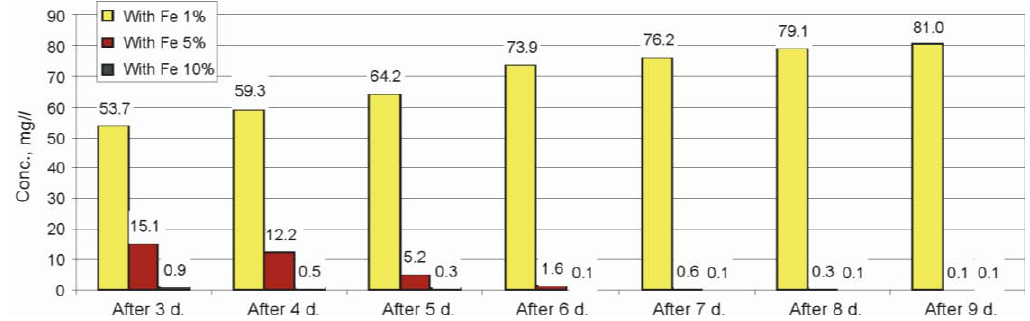
Fig. 5. Cu salt concentration variations during the experiment. Solution of 232.1 mg/ l concentration was passed through sand with different quantity of iron